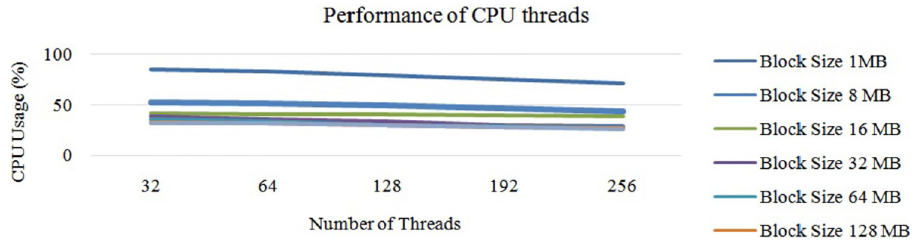
Fig 19. Maximum number of map tasks that should run simultaneously by a task tracker.